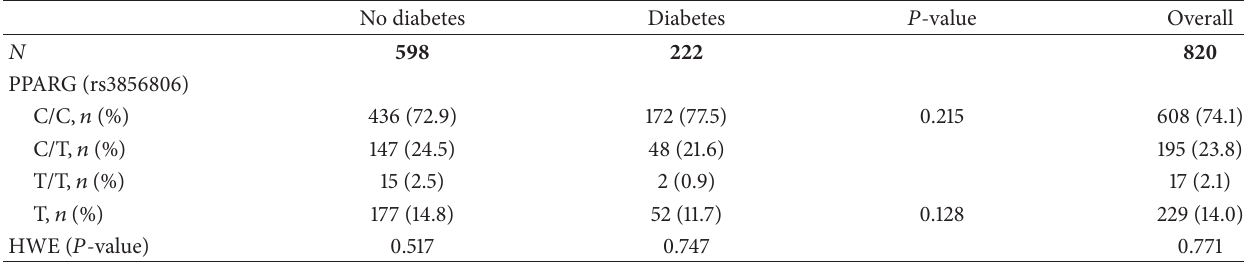
Table2:Genotypedistributions,minorallelefrequencies,andunadjusted 𝑃 -valuesforcomparinggenotypedistributionaccordingtodiabetes status and additive allelic effects between diabetes